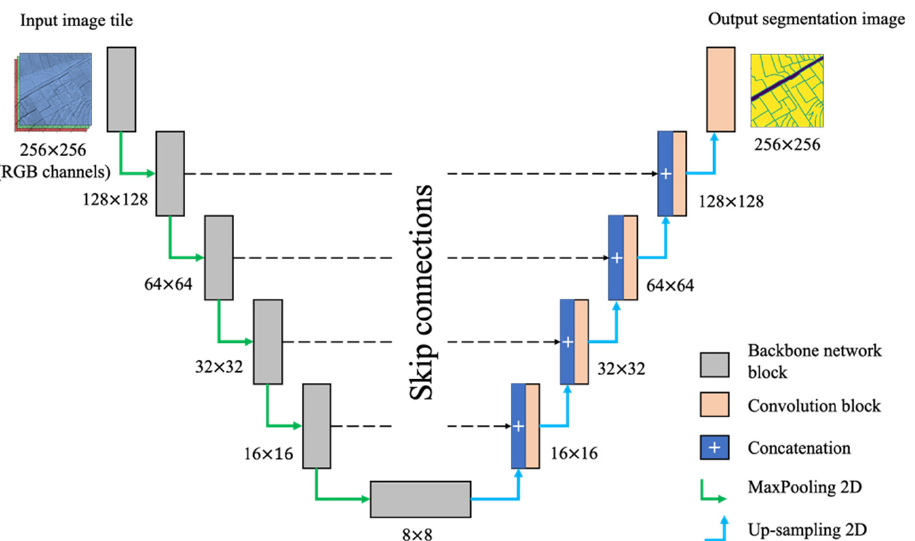
Figure 5. The U-net model for satellite image segmentation. The left part is backbone network blocks with skip connections to the decoder part on the right. Input is the 256 × 256 pixels of RGB channels, and output is predictions of three classes representing the agricultural field, field boundary, and background.